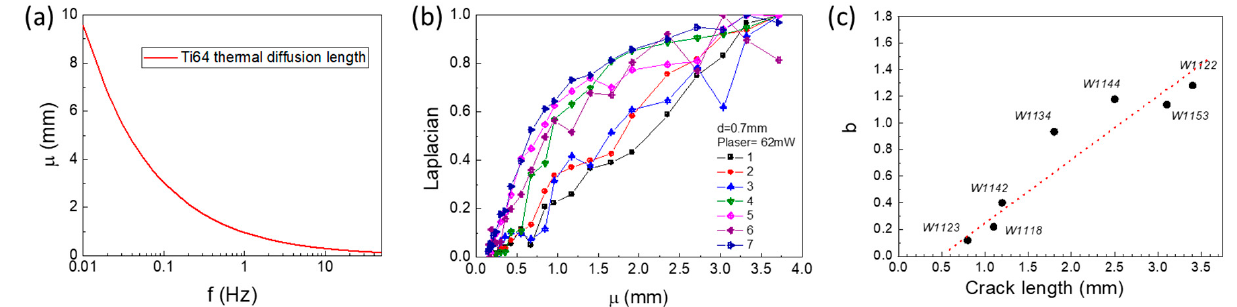
Figure 7. ( a ) Calculated thermal di ff usion length µ as a function of modulation frequency f. For the sample cracks listed in Table 1, ( b ) normalized Laplacian of a crack as a function of thermal di ff usion length µ for various cracks. Lock-in measurement taken at d = 0.7 mm and laser power 62 mW. ( c ) Correlation of parameter b to the crack length.